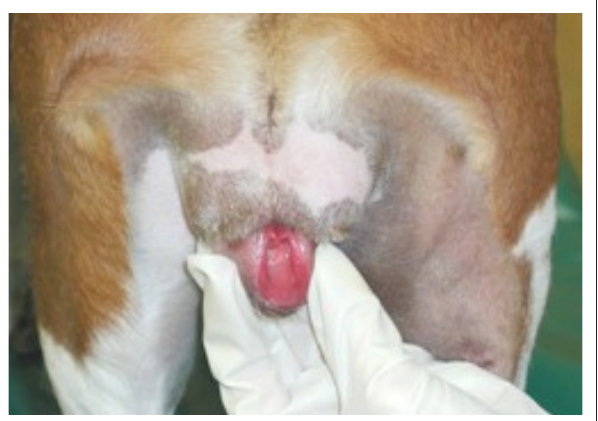
FIGURE 4: Vulva: Canine, diffuse small T-cell lymphoma (Tissue section).